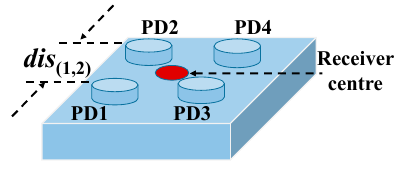
Figure 3. Receiver structure.